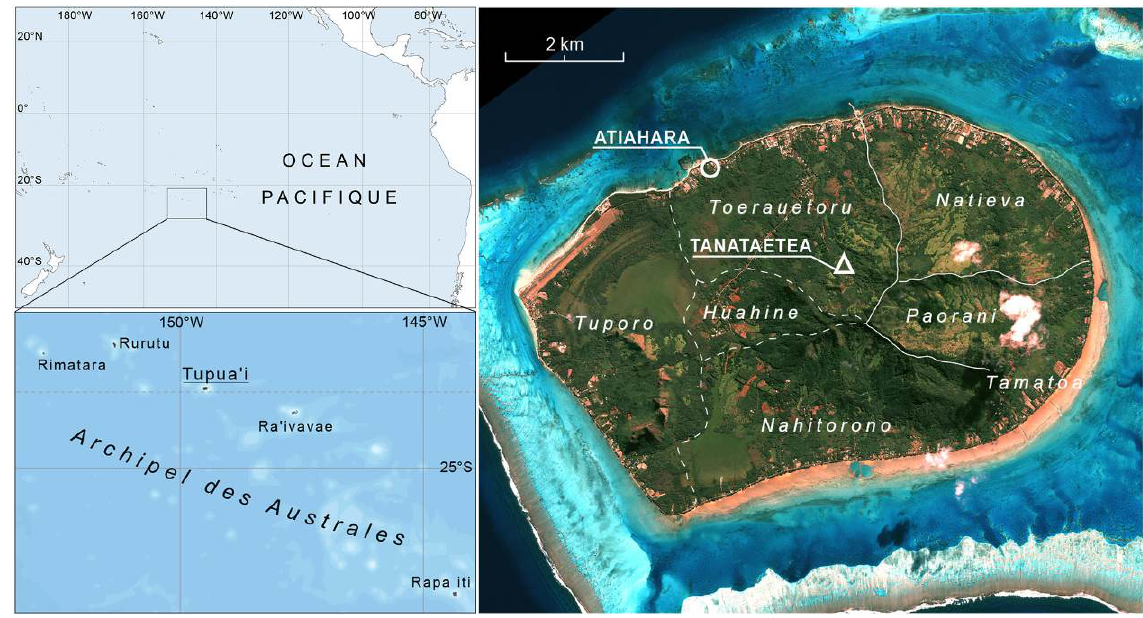
Figure 1. Carte de Tupua'i et localisation des sites étudiés (image Quickbird). Figure 1. Tupua'i island and location of the